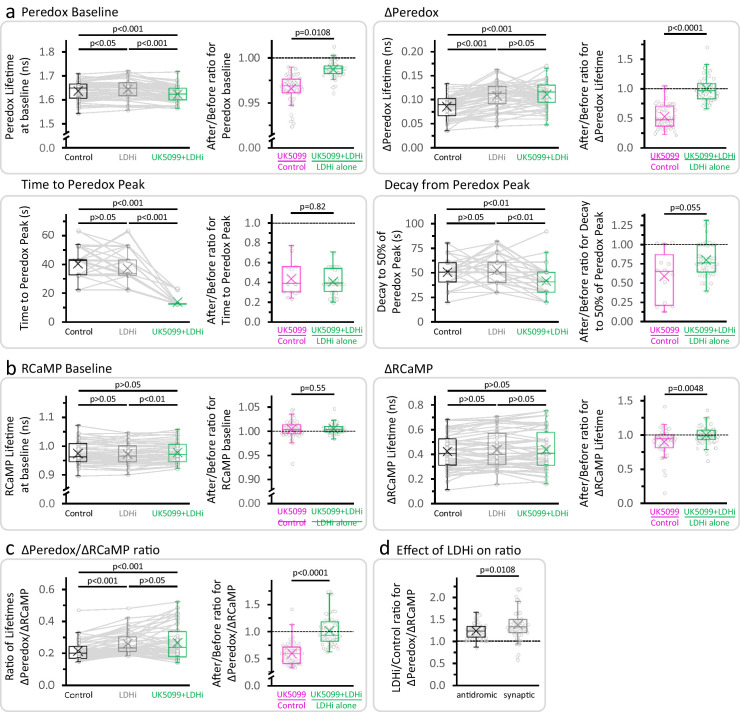
LDH inhibition prevents the effect of UK5099 on the amplitude of the NADHCYT transient, but not on its time course.(a–b) Effects of the sequential application of 2 µM GSK-2837808A and 2 µM UK5099 (as in Figure 2d) on the parameters derived from the Peredox and RCaMP transients, respectively. The full dataset of Figure 2d was used (Nneurons = 52, Nslices = 6 and Nmice = 5), except for comparisons of the time to peak and decay of the NADHCYT response, when only neurons that presented a ΔPeredox Lifetime ≥ 0.05 ns during all the experiment were included (Nneurons = 49, Nslices = 6 and Nmice = 5). For multiple comparisons of normally distributed data, a repeated measures ANOVA was used, with a Student-Newman-Keuls post-test. The data were compared using a non-parametric repeated measures ANOVA (Friedman test) with a Dunn post-test otherwise. The ratio (after UK5099)/(before UK5099) was included for each parameter, to compare the conditions UK5099/Control and (UK5099+LDHi)/LDHi alone (as in Figure 2e). For UK5099/Control, the full dataset of Figure 2c was used (Nneurons = 48, Nslices = 7 and Nmice = 6), except for comparisons of the time to peak and decay of the NADHCYT response, when only neurons that presented a ΔPeredox Lifetime ≥ 0.05 ns after UK5099 were analyzed (Nneurons = 13, Nslices = 3 and Nmice = 3). A Student’s t test or a Welch’s t-test were used for comparisons between normally distributed data, or a non-parametric Mann-Whitney test was used otherwise. (c) Effects of the sequential application of GSK-2837808A and UK5099 (as in Figure 2d) on the ratio of lifetimes ΔPeredox/ΔRCaMP. (d) Comparison of the size effect of LDH inhibition on the NADHCYT transients elicited with antidromic stimulation (data from experiments in Figure 2d, Nneurons = 52, Nslices = 6 and Nmice = 5) or synaptic stimulation (data from Figure 4 3F in Díaz-García et al., 2017, Nneurons = 54, Nslices = 5 and Nmice = 5), using a Mann-Whitney test.